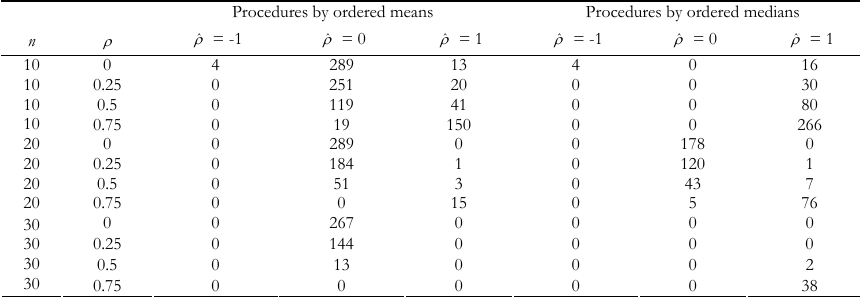
Simulations number with ˆ  = -1, 0, 1 for N = 1000 Procedures by ordered means Procedures by ordered